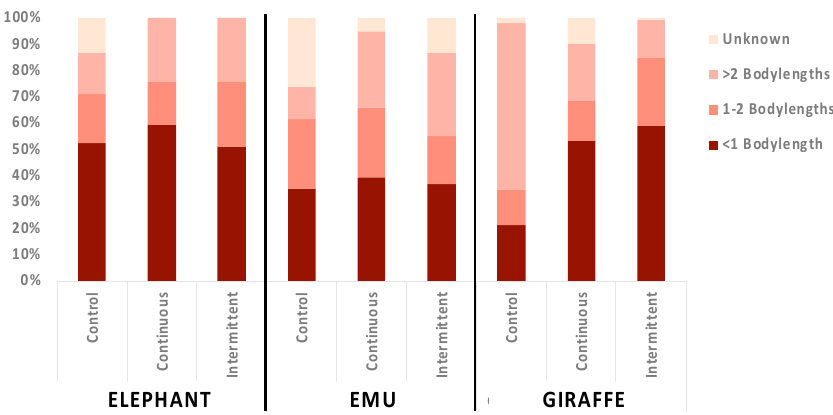
Figure 9. Time spent in proximity to the nearest conspecific during control, continuous, and intermittent